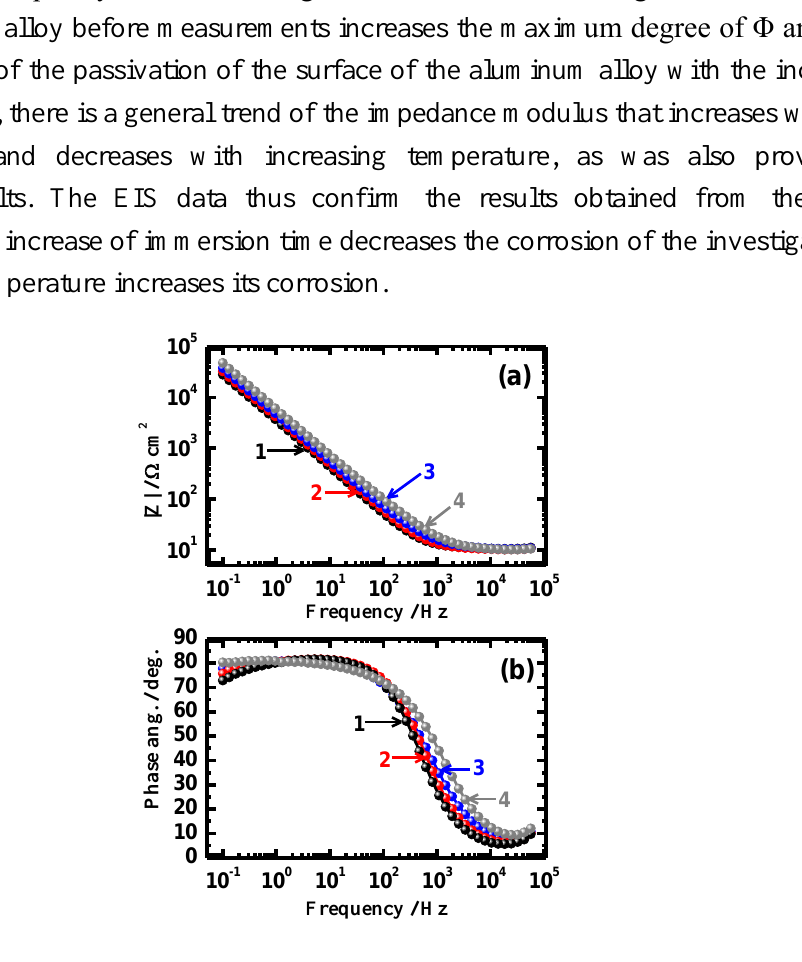
Figure 9. Bode ( a ) impedance of the interface and ( b ) the phase angle plots for γ-TiAl alloy after (1) 0.0 h; (2) 1.0 h; (3) 4.0 h; and (4) 24 h immersion in 3.5% NaCl solution at room